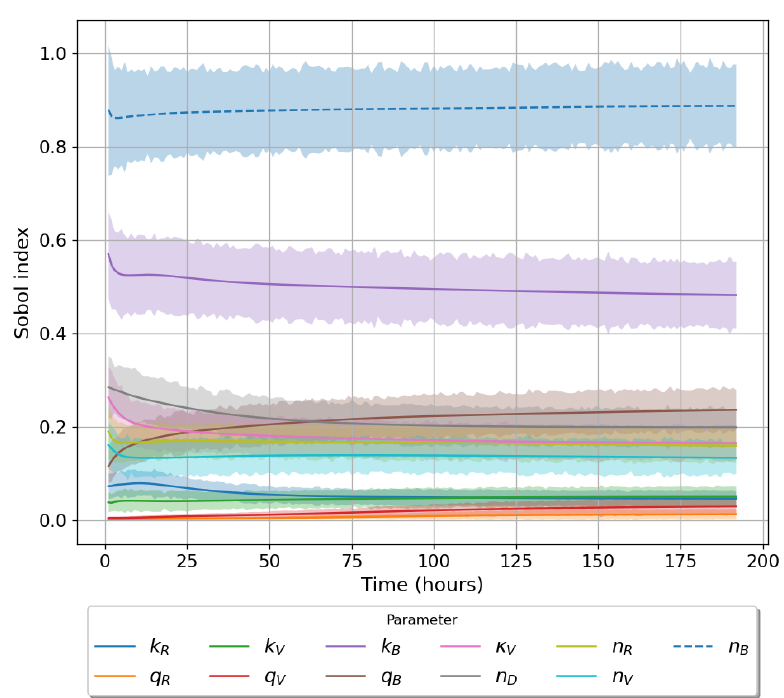
Figure 4. Time evolution of total order Sobol sensitivity indices (model 1). Model output for this model is activated TBK1, n B ∗ . Shaded region accounts for a 95% confidence interval.